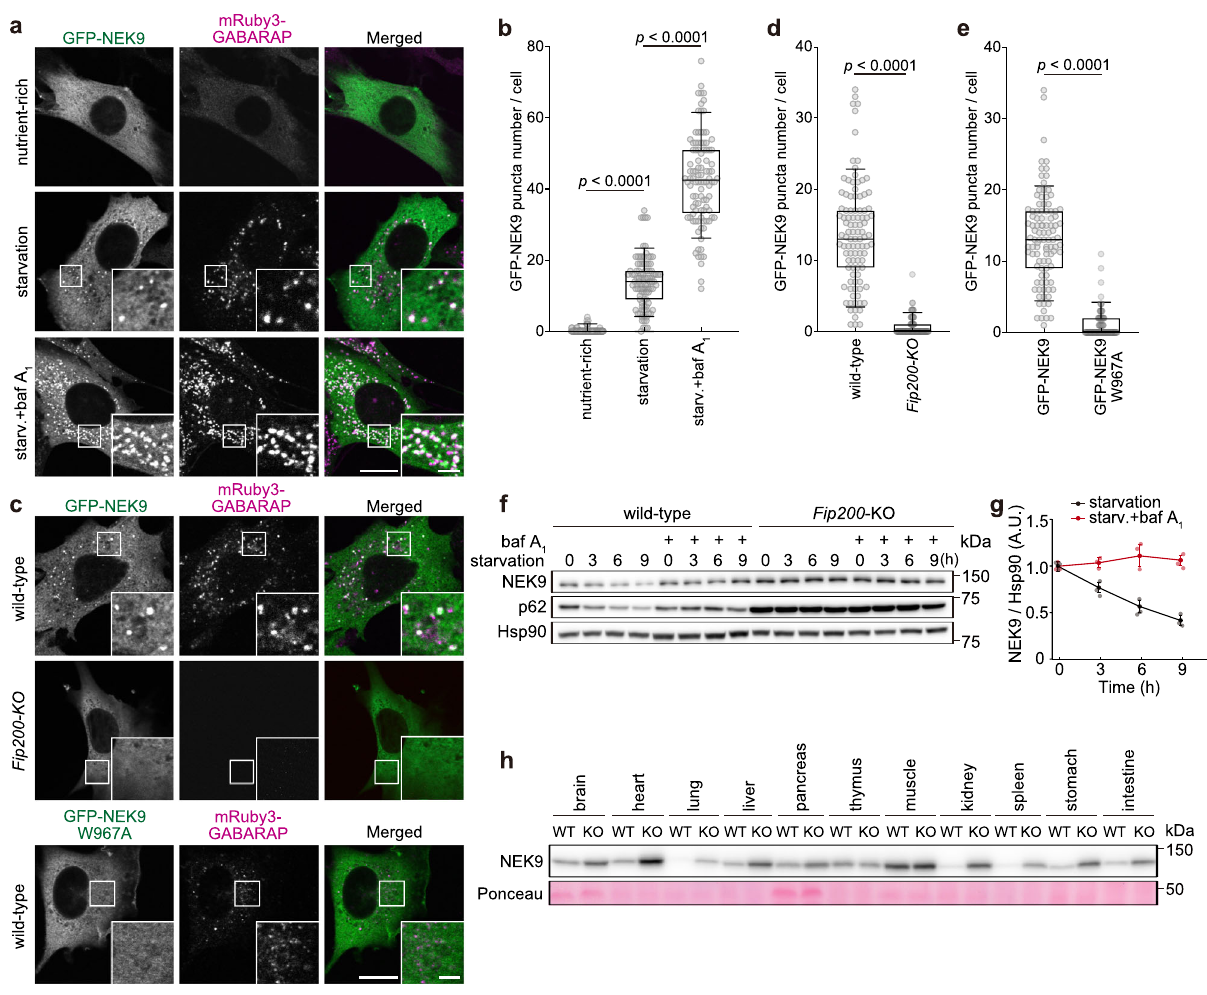
Fig. 2 NEK9 is degraded by selective autophagy. a Immuno fl uorescence microscopy of MEFs expressing GFP-NEK9 and mRuby3-GABARAP under nutrient-rich conditions and amino acid and serum starvation (2 h) conditions with or without 100 nM ba fi lomycin A 1 (baf A 1 ). b Quanti fi cation of the number of NEK9 puncta in ( a ); p values correspond to a Tukey ’ s multiple comparisons test. c Immuno fl uorescence microscopy of wild-type and Fip200- KO MEFs expressing GFP-NEK9 (top), and wild-type MEFs expressing GFP-NEK9 W967A (LIR-mutant) (bottom) after starvation (2 h). d , e Quanti fi cation of the number of NEK9 puncta in ( c ); p values correspond to two-tailed Mann – Whitney tests. f Wild-type and Fip200- KO MEFs were incubated under starvation conditions with or without 100 nM ba fi lomycin A 1 for the indicated time. Whole-cell lysates were subjected to immunoblotting. g Quanti fi cation of the intensity of the NEK9 bands in ( f ). Data represent the mean ± SEM values of three independent experiments. h Immunoblotting of indicated organs of three-month-old Atg5 + / + (WT) and Atg5 − / − ;NSE-Atg5 (KO) mice. Data are representative of three biologically independent replicates. For ( b , d , and e ), data were collected from 100 cells for each condition. Solid bars indicate the medians, boxes the interquartile range (25th to 75th percentile), and whiskers the 10th to 90th percentile. Scale bars, 10 µ m and 3 µ m